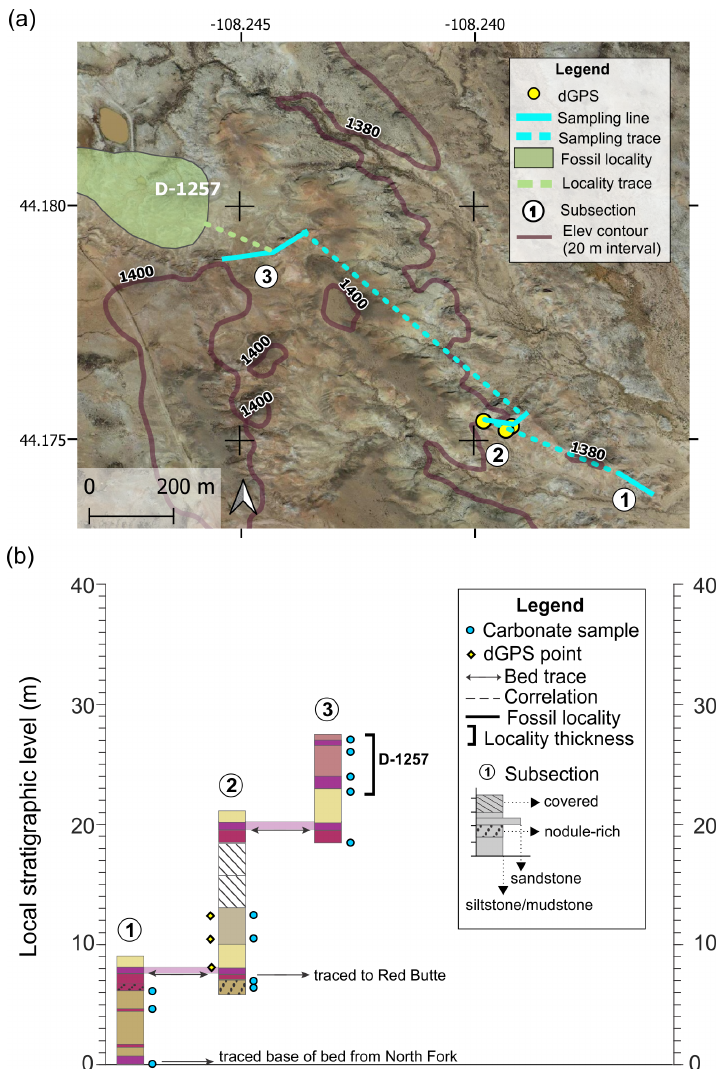
Figure A5. Upper North Fork section (a) map and (b) diagram showing sampling subsections, dGPS tie points, bed traces, and correlated fossil localities. Colored boxes in (b) represent the surface color of weathered rocks. Marker beds used to trace between subsections are shown in light shading with arrows along the bed surface used for tracing. Basemap source: Google Earth © 2021. A high-resolution map is available in the supplemental data repository (Widlansky et al.,